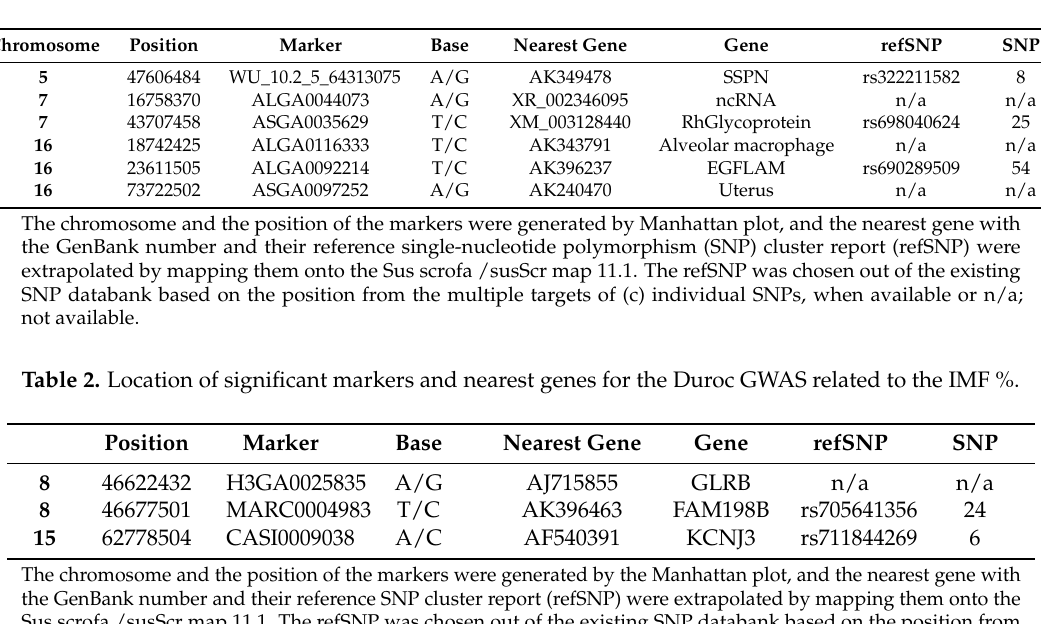
Table 1. Location of significant markers and the nearest genes, identified by meta-analysis of the genome-wide association study (GWAS) related to the IMF % in commercial pig sires.